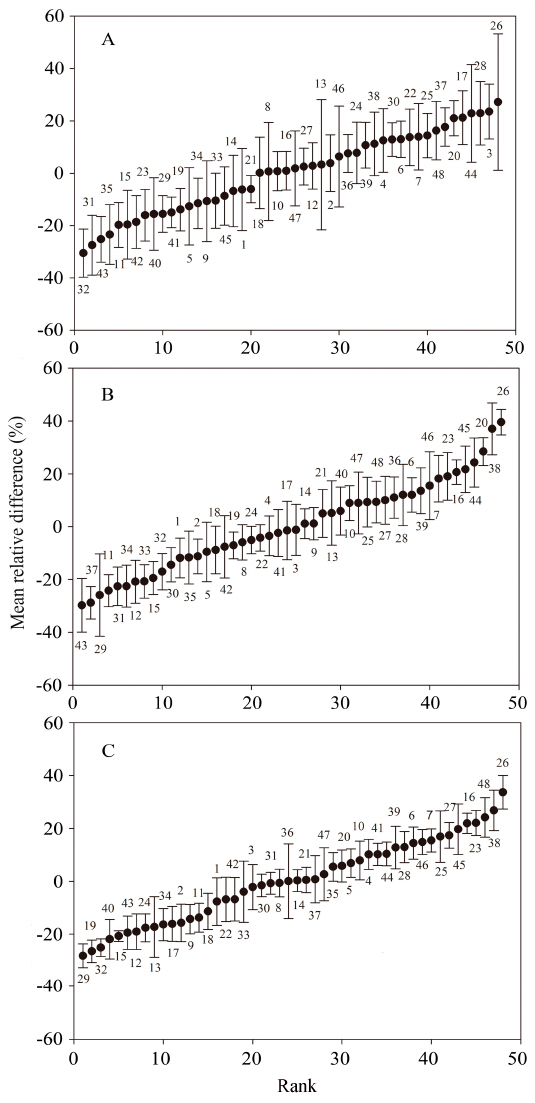
Figure 7. Ranked mean relative difference (MRD) of VSM of 48 points with standard deviations (SDRD) at the soil layers of 0–20 cm ( A ), 20–40 cm ( B ), and 40–60 cm ( C ).